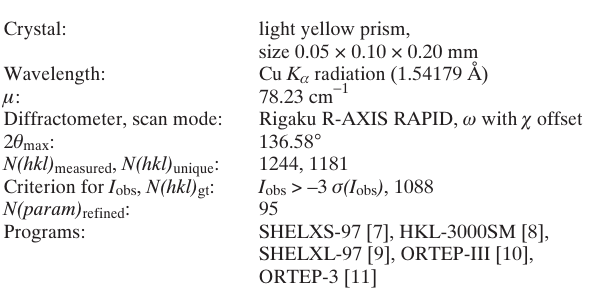
Table 1. Datacollection and handling.